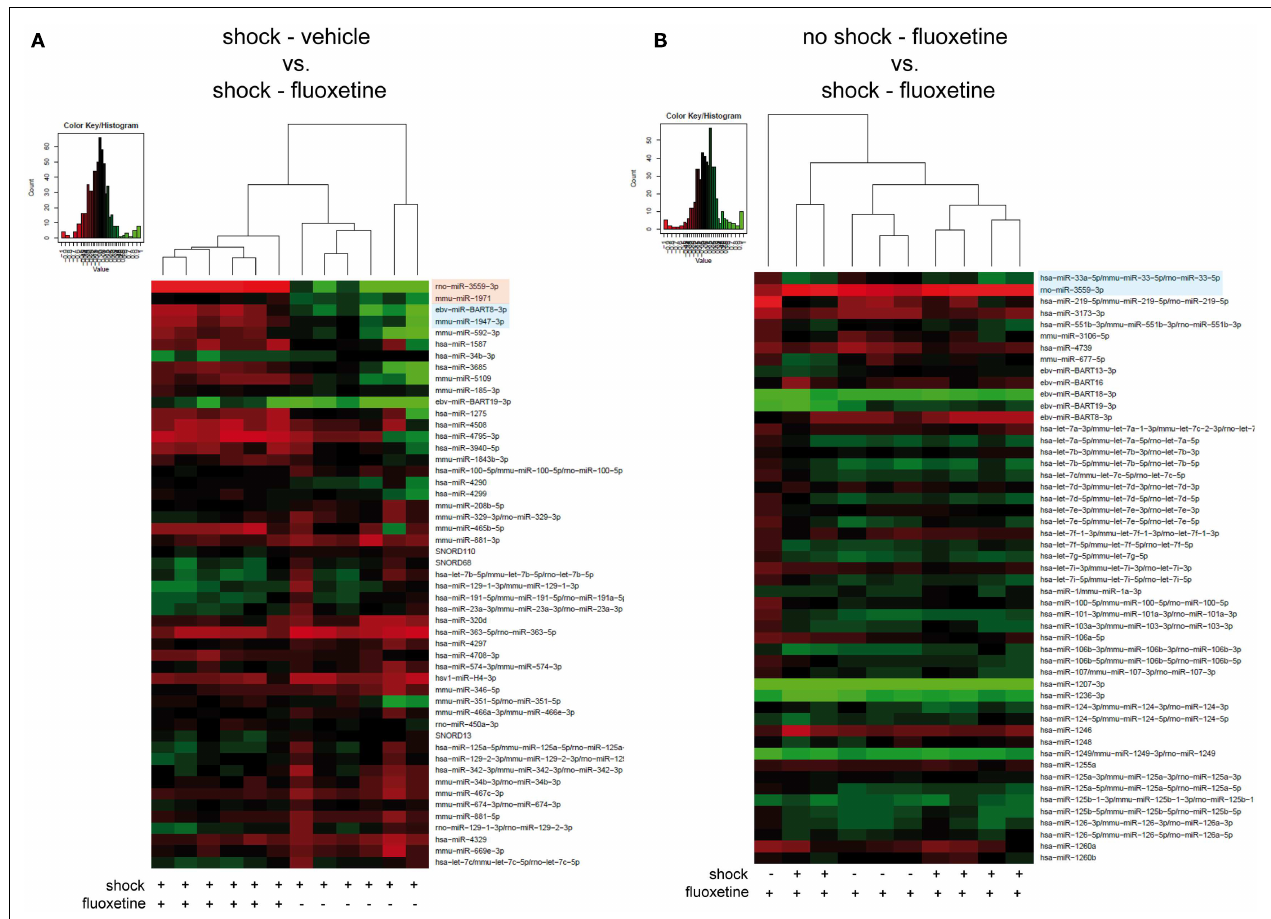
represents a miRNA and each column represents a sample. Dendrograms represent complete-linkage clustering (by Euclidean distance) between samples.The sample clustering tree is shown on the top.The color scale illustrates the intensities of the relative miRNA expression levels: decreased scores are represented in red and increased in green, with intensity encoding magnitude. Significant alterations in miRNA expression levels determined by pairwise t -tests are highlighted in bright pink (corr. p < 0.05), statistical trends (corr. p < 0.1) in bright blue. Note that two samples of the no-shock-fluoxetine group were excluded during data processing (shock-vehicle: n = 6 per group; shock-fluoxetine: n = 6; no-shock-fluoxetine: n = 4). Statistical procedures are explained in the Section “Materials and Methods” and data are presented in the Section “Results”Vehicle, drinking water (solvent of